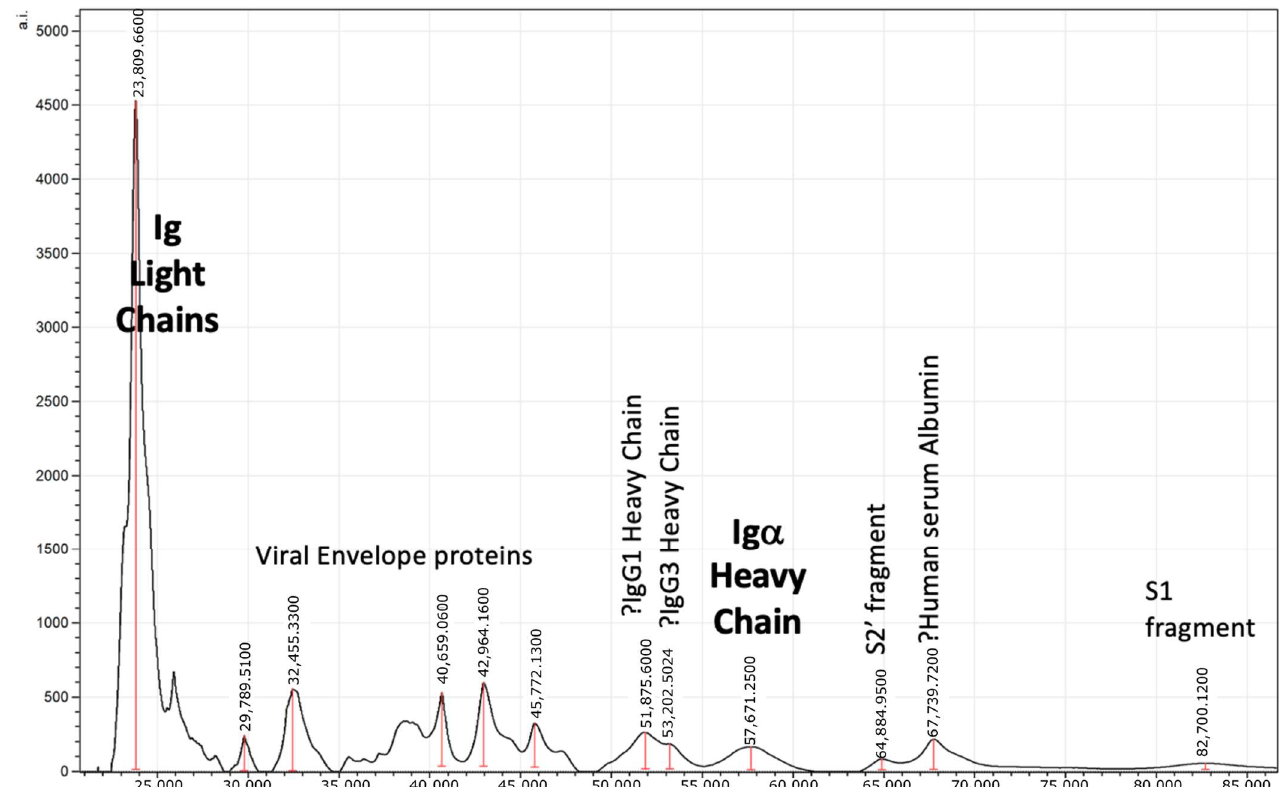
Figure 4. Example spectra of swab sample from SARS-CoV-2 RT-qPCR Brazilian patient with peak identification annotation after allowing for a 3–4% drift in higher mass calibration. S1—Spike protein fragment 1; S2—Spike protein fragment